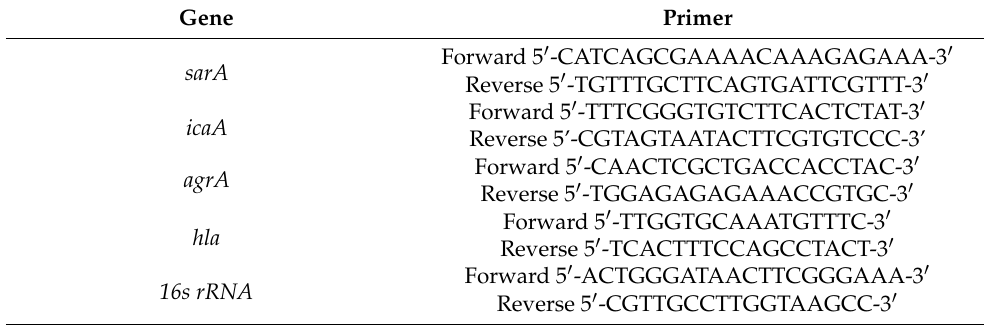
Table 1. Primer sequences for quantitative